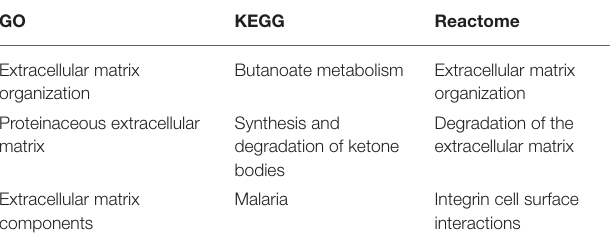
organization Degradation of the extracellular matrix